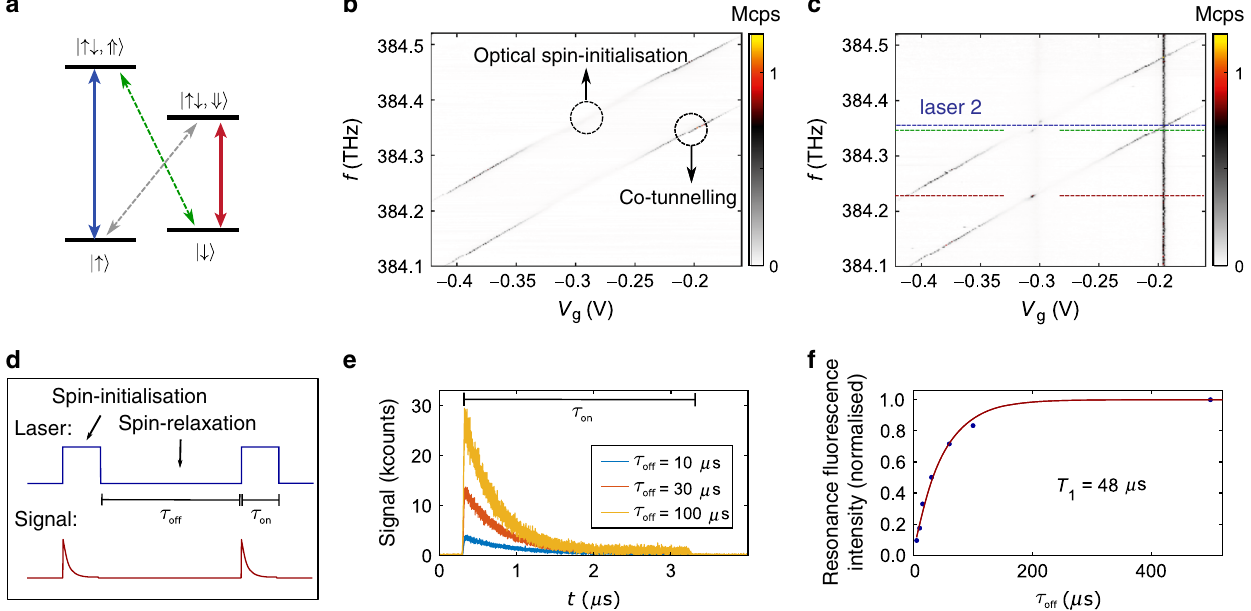
Fig. 3 Initialisation of a single electron spin. a Level scheme of the negative trion X 1 − in a magnetic fi eld (Faraday geometry). b Optical spin-initialisation via optical pumping on X 1 − . The measurement is carried out at B = 6.6 T. In the plateau centre, the resonance fl uorescence disappears due to successful spin-initialisation; at the plateau edges it remains bright due to rapid spin-randomisation via co-tunnelling 41 . c Optical spin-initialisation and re-pumping with a second laser at a fi xed frequency (laser 2). Recoveries of the signal are found in the plateau centre. d Schematic of the time-resolved spin-pumping measurement. e Resonance fl uorescence intensity as a function of time. The signal drops due to optical spin-initialisation after turning the driving laser on. The overall intensity is larger when the time-delay τ off between the laser pulses is larger. In this case, the electron spin has more time to relax back from the off-resonant state. f Resonance fl uorescence intensity as a function of the waiting time between the spin-pumping laser pulses. The magenta line is an exponential fi t to the data (blue dots). From this measurement we extract an electron-spin lifetime of T 1 ~ 48 ± 5 μ